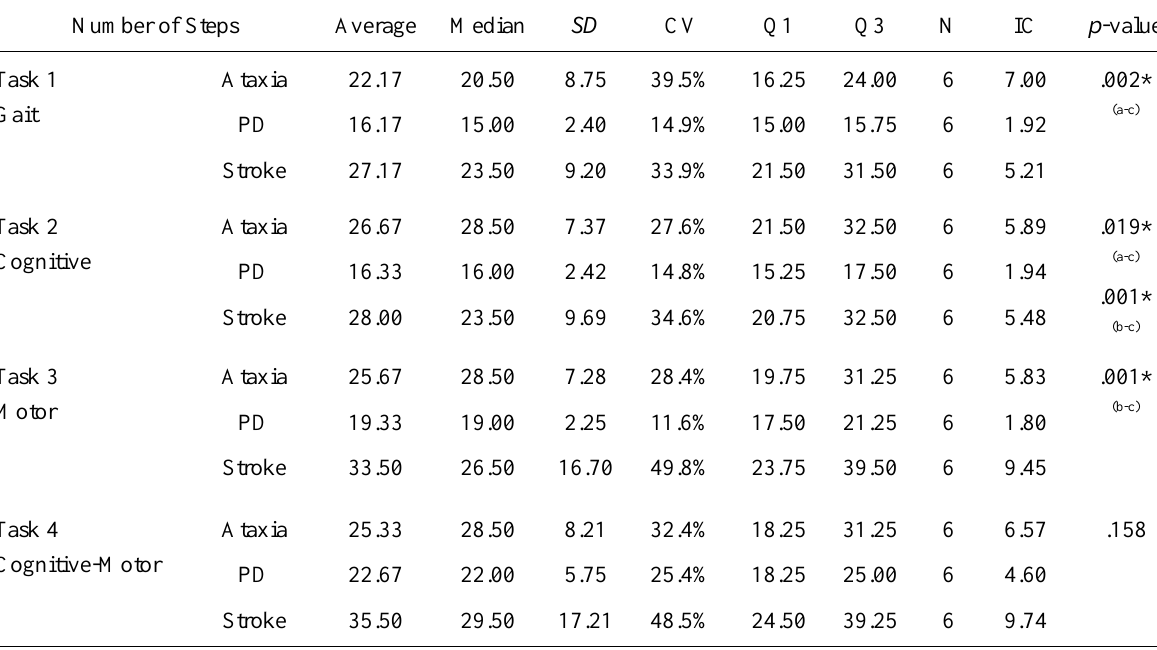
Gait Performance Related to Number of Steps in the Four Tasks for Ataxia, PD and Stroke Groups Number of Steps